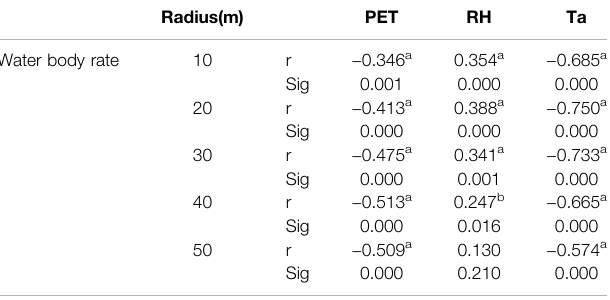
TABLE 7 | Correlation coef fi cients between water body rate and simulated data within different buffer radiuses. Radius(m) PET RH Ta Water body rate